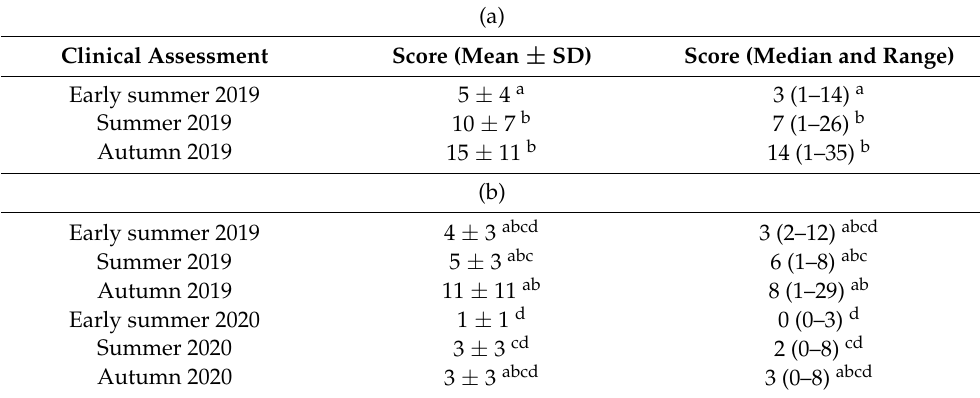
Table 5. Scores recorded in clinical assessments (general linear mixed model (Proc Mixed)) of (a) 15 insect bite hypersensitivity (IBH)-affected horses in early summer, summer and autumn